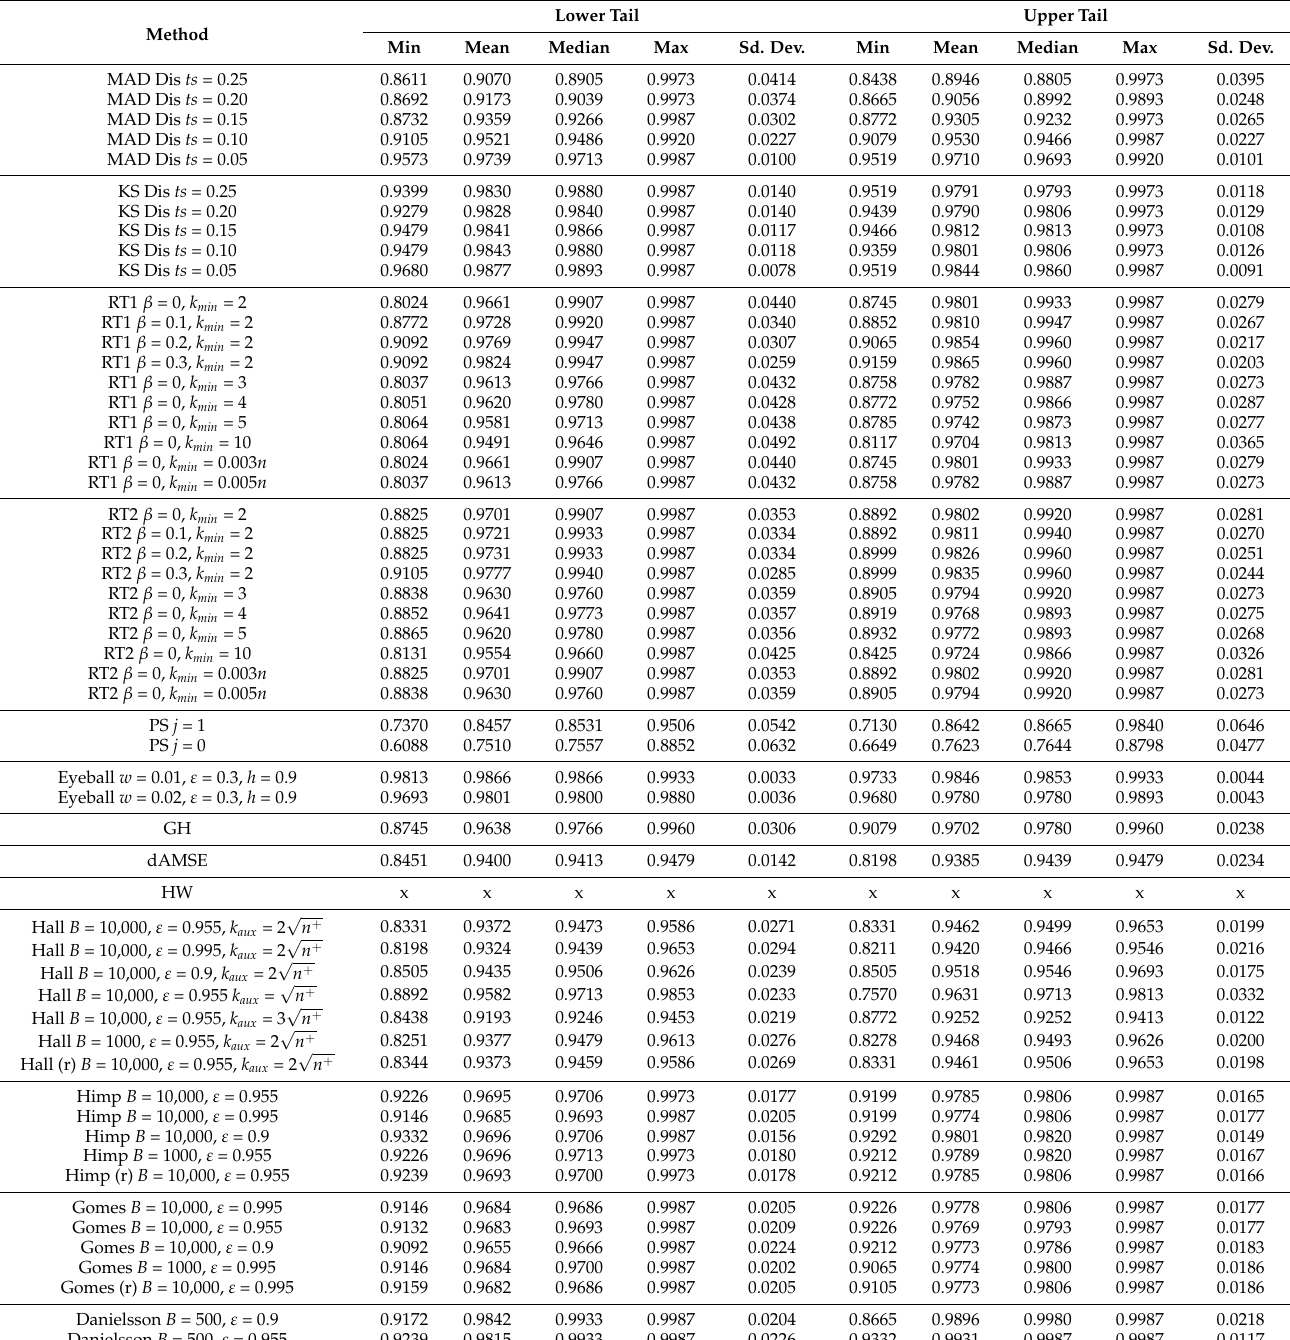
Table 3. Estimates of the threshold under different methods in the first